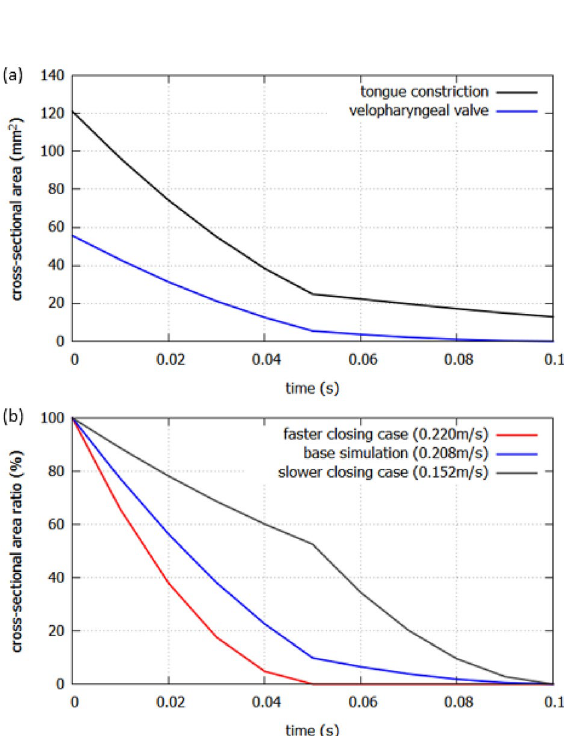
Figure 2. ( a ) The cross-sectional area of the tongue constriction and the velopharyngeal valve during the movement. ( b ) The cross-sectional area ratio of different closing